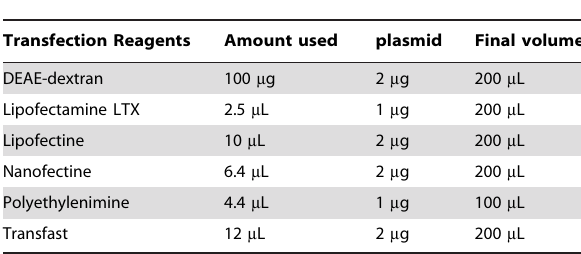
Table 1. Transfection reagents used to transfect